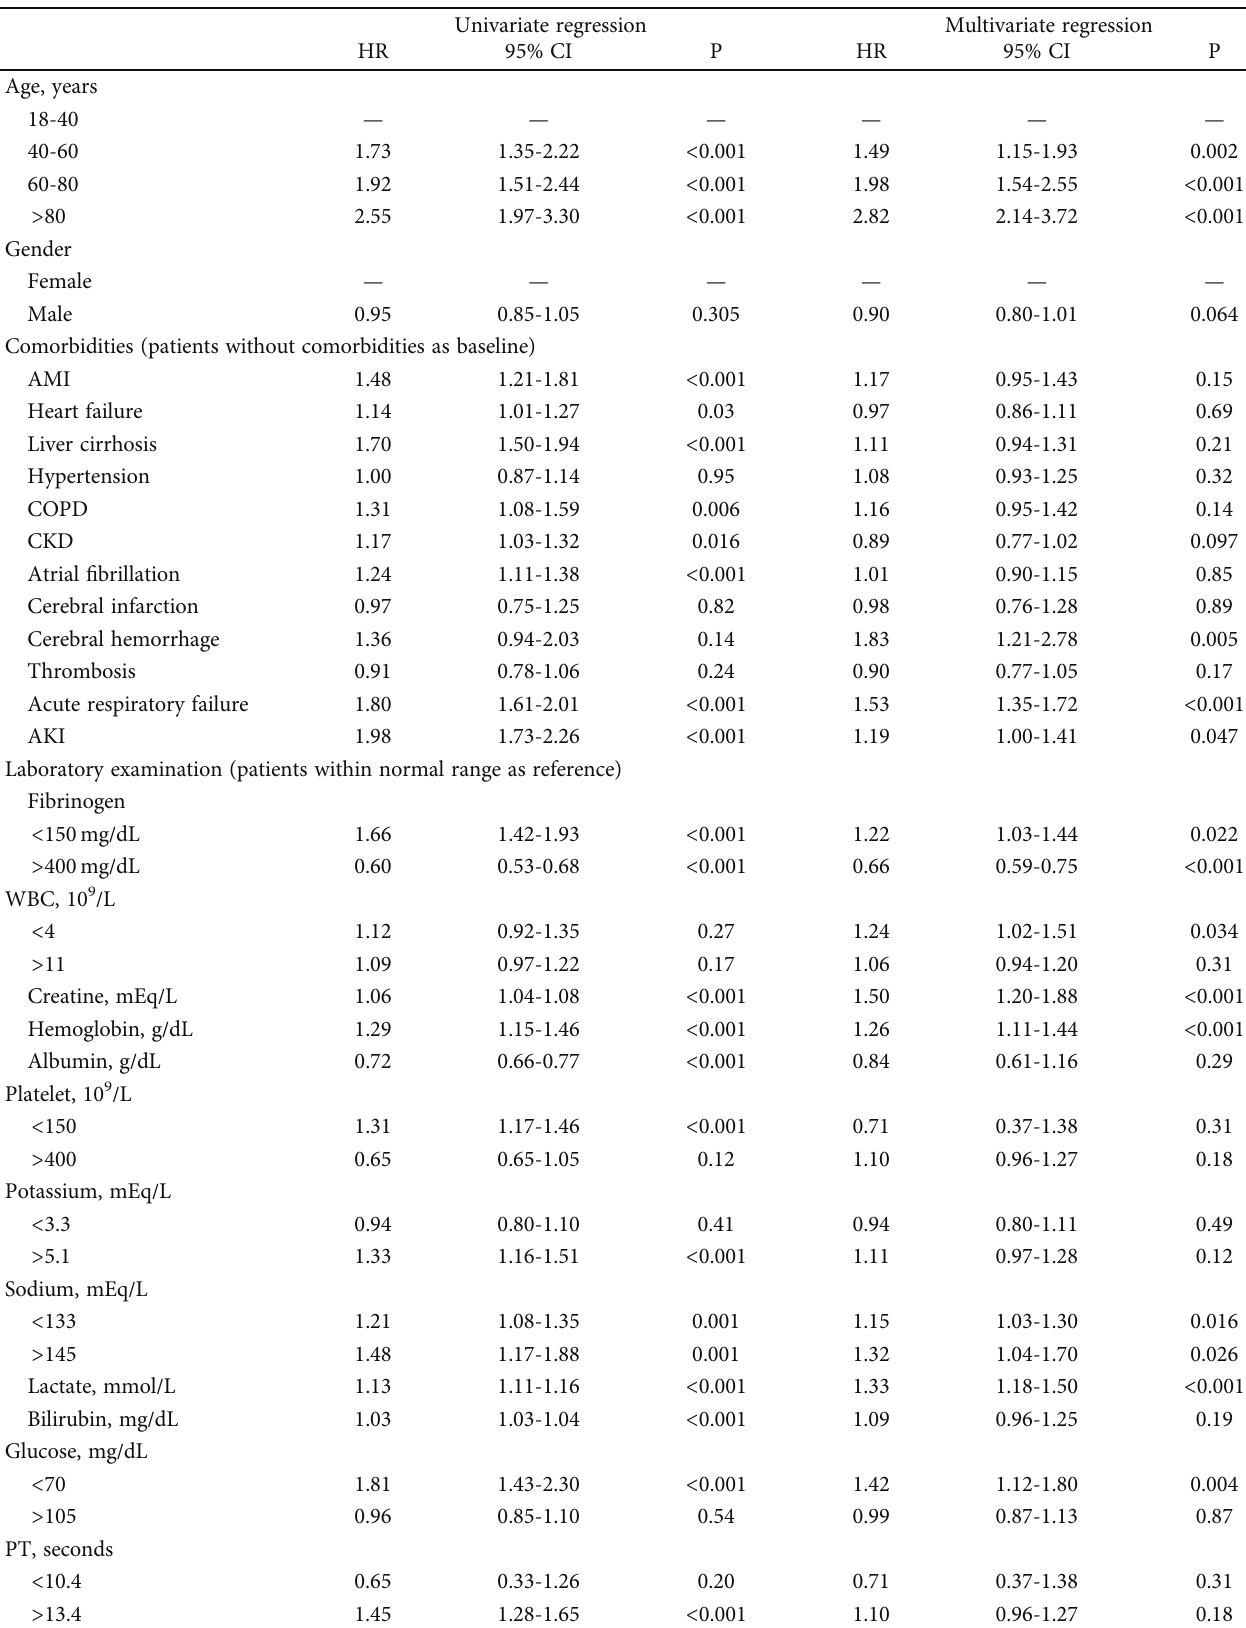
Table 4: Cox analysis of all included